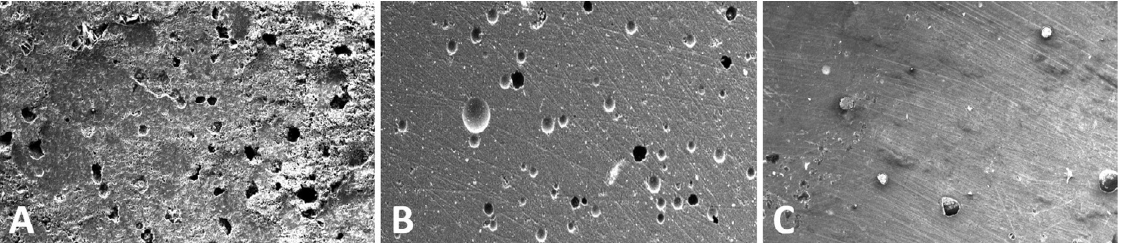
Figure 4- Porosity of (A) White mineral trioxide aggregate (MTA) Angelus, (B) Biodentine (BIO), and (C) Zinc oxide-eugenol (ZOE) cements by scanning electron microscopy (SEM) evaluation at 50x